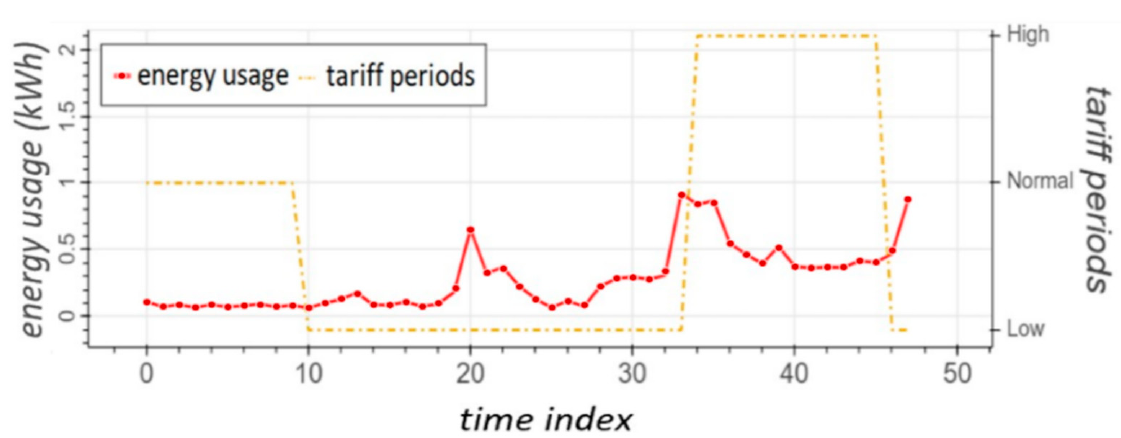
Figure 1. Example of a single day usage from the dataset (sampling interval of 30 min) of a consumer. Dotted line represents corresponding tariff period (0—low, 1—normal, and 2—high price periods, respectively).